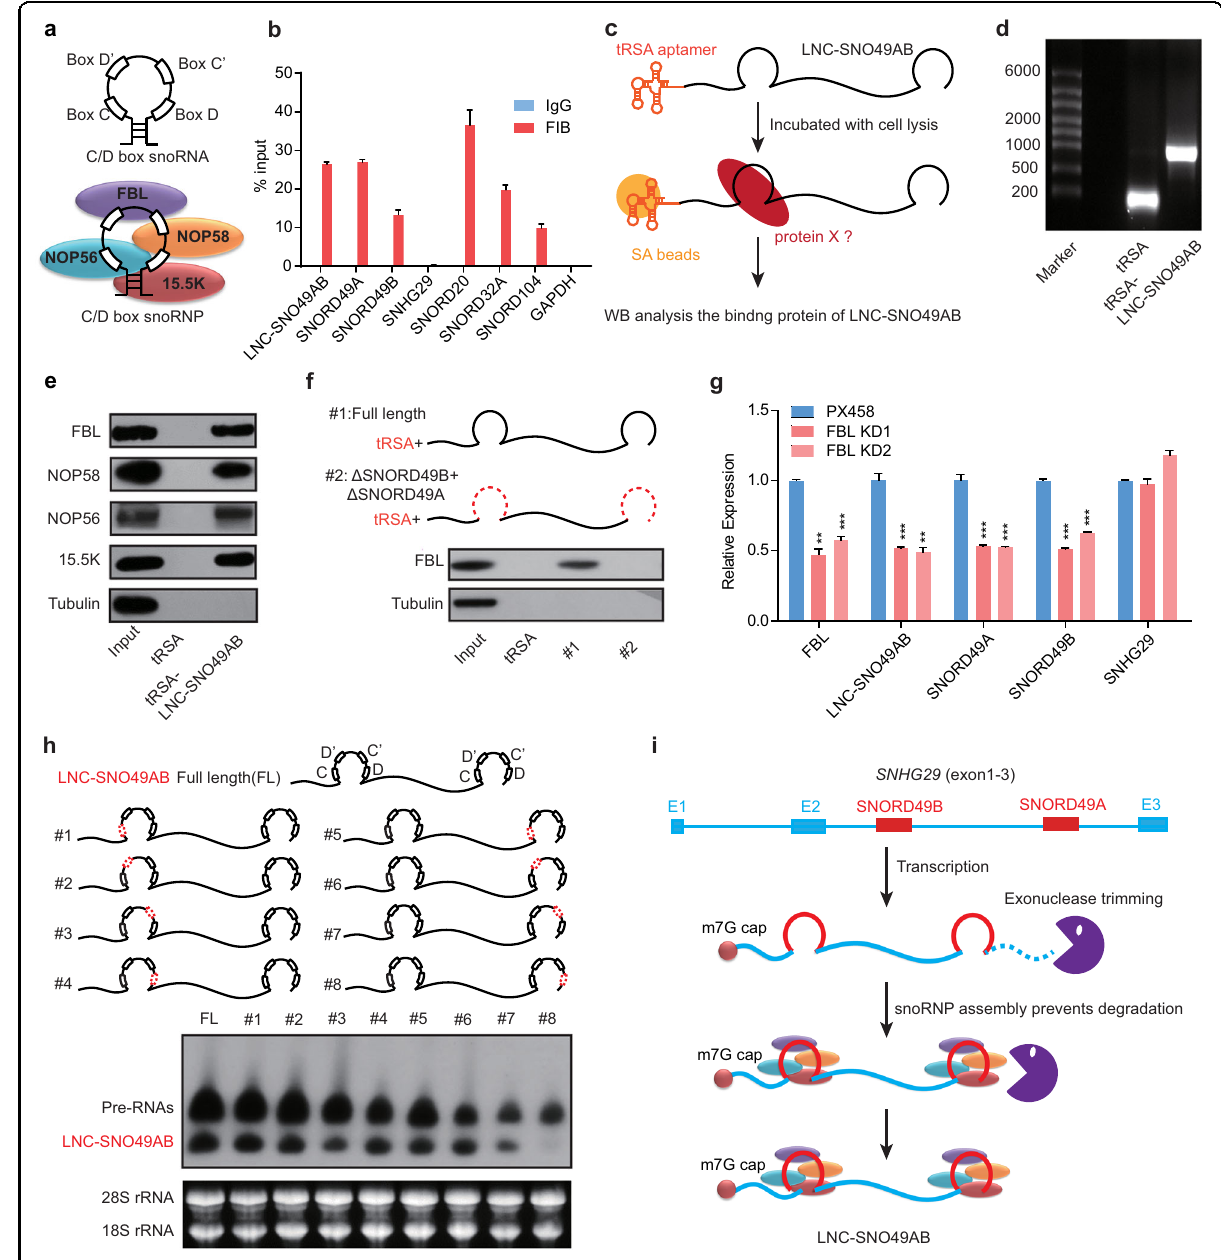
Fig. 2 The role of SNORD49A/B in LNC-SNO49AB processing. a Schematic representation of C/D box snoRNA (upper) and snoRNP (below). b FBL RIP followed by RT-qPCR analysis of copuri fi ed RNA in RS4;11 cells. Representative results are shown from three replicates. c Schematic representation of the tRSA RNA pull-down assay. d Formaldehyde denaturing agarose gel analysis of the in vitro-transcribed tRSA and LNC-SNO49AB. Representative results are shown from three replicates. e The results of western blot showed that FBL, NOP58/56 and 15.5 K proteins in the cell lysis were precipitated by in vitro-transcribed LNC-SNO49AB. f Schematic of deletion mutants of LNC-SNO49AB (upper). The FBL binding capability of truncated LNC-SNO49AB is shown below. Tubulin was used as a negative control. g qRT-PCR analysis of FBL, LNC-SNO49AB, SNORD49A/B and SNHG29 in RS4;11 cells treated with FBL sgRNA. The empty PX458 vector was transfected as control. Data were normalized to GAPDH mRNA. Values are the means ± SEM of three independent experiments. * P < 0.05, ** P < 0.01, and *** P < 0.001 by Student ’ s t -test. h Schematic of full-leng t h LNC-SNO49AB (upper) and deletions of box C/D (middle, #1 – 8, red dashed lines). Northern blot of LNC-SNO49AB and the indicated mutants(bottom), 28S and 18S rRNA were acted as the total RNA controls. Representative results are shown from three replicates. i Schematic of the biogenesis and processing of